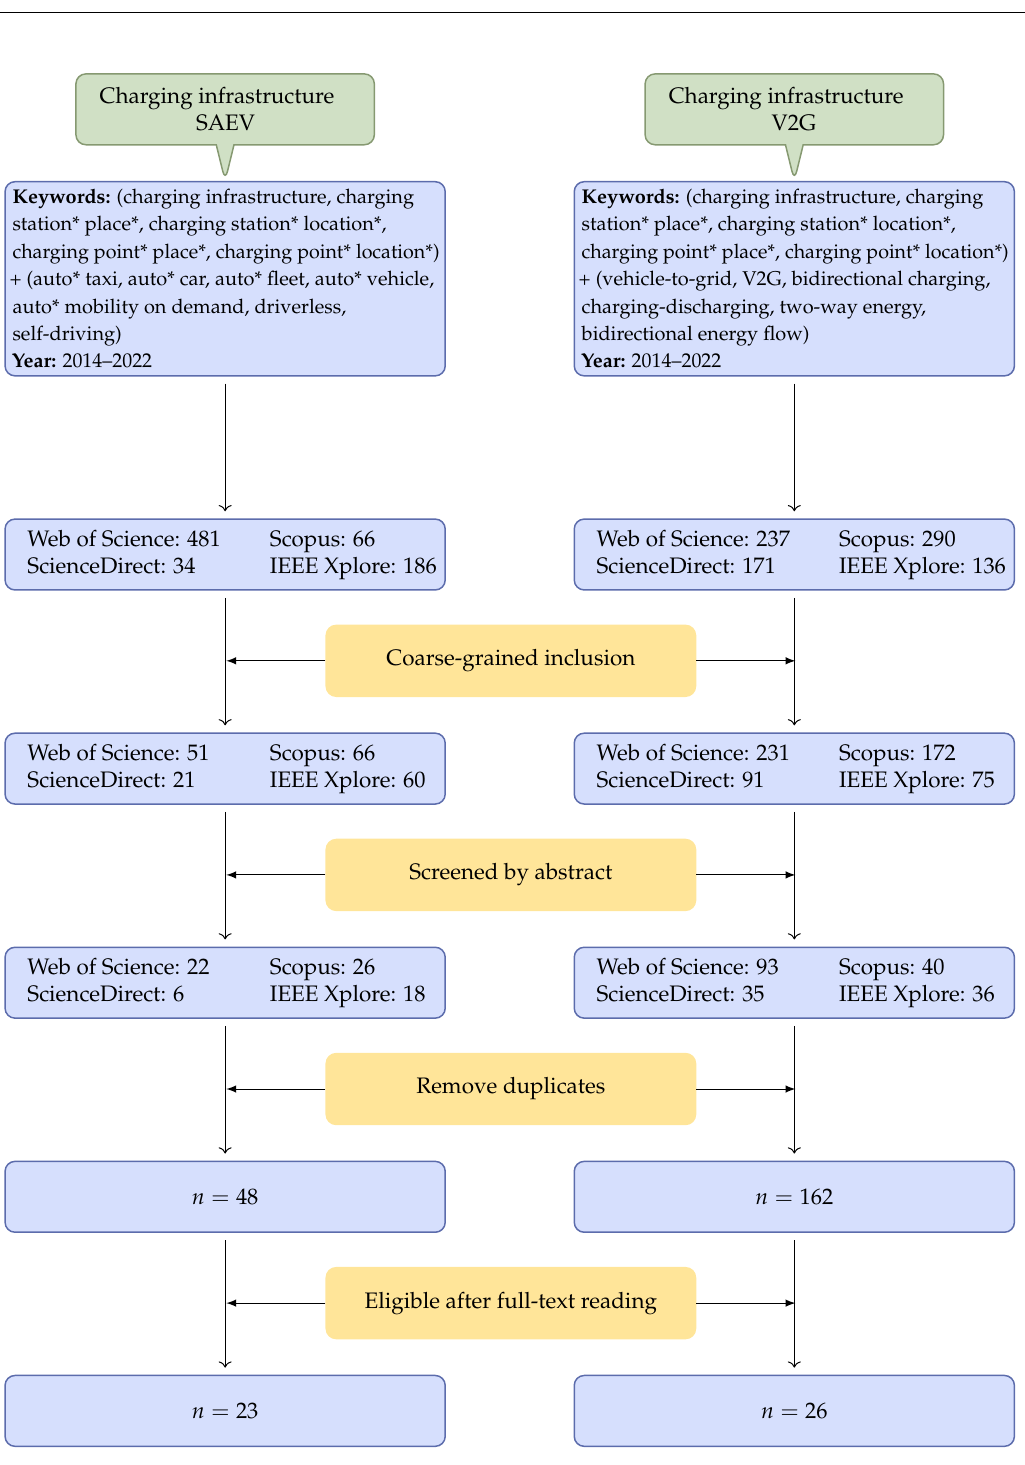
Figure 5. Overview of the search for papers about charging infrastructure allocation for SAEVs ( left ) and about charging infrastructure allocation with implementation of V2G ( right